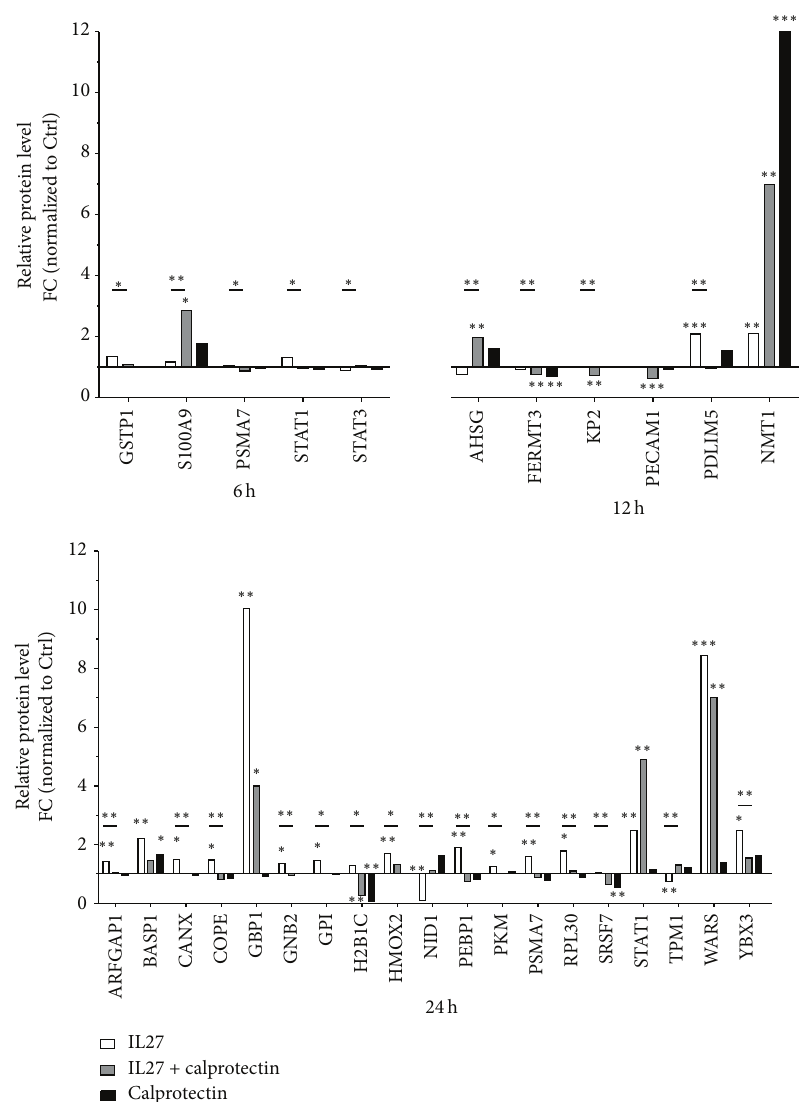
Figure 5: Label-free quantified proteins represented as relative protein levels. The calprotectin significant modulatory effects on mutual proteins in HUVECs stimulated with IL27 (30 ng/mL) ± calprotectin (1 𝜇 g/mL) are shown for 6, 12, and 24 h ( 𝑛 = 9 ). Significance is indicated by 𝑞 -value: ∗ 𝑞 < 0.15 , ∗∗ 𝑞 < 0.10 , and ∗∗∗ 𝑞 < 0.01 . Significance is indicated for each stimulation by stars and between IL27 and IL27 + calprotectin stimulation by stars with a line. AHSG, alpha-2-HS-glycoprotein; ARFGAP1, ADP-ribosylation factor GTPase-activating protein 1; BASP1, brain acid soluble protein 1; CANX, calnexin; COPE, coatomer subunit epsilon; FERMT3, fermitin family homolog 3; GBP1, interferon-induced guanylate binding protein 1; GNB2, guanine nucleotide-binding protein, subunit beta-2; GPI, glucose-6-phosphate isomerase; GSTP1, glutathione S-transferase P; H2B1C, histone H2B type 1; HMOX2, heme oxygenase 2; KP2, importin subunit alpha-1; NID1, nidogen-1;NMT1,glycylpeptideN-tetradecanoyltransferase1; PDLIM5,PDZandLIMdomainprotein5; PEBP1,phosphatidylethanolamine- binding protein 1; PECAM1, platelet/endothelial cell adhesion molecule; PSMA7, proteasome subunit alpha type-7; RPL30, 60S ribosomal protein L30; S100A9, S100 calcium binding protein A9; SRSF7, serine/arginine-rich splicing factor 7; STAT, signal transducers and activators of transcription; TPM1, tropomyosin 1; WARS, tryptophan tRNA ligase, cytoplasmic; YBX3, Y-box-binding protein